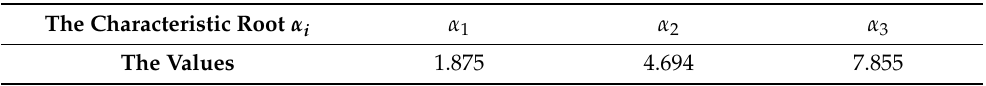
Table 1. Eigenroot values of the first three orders of flexible